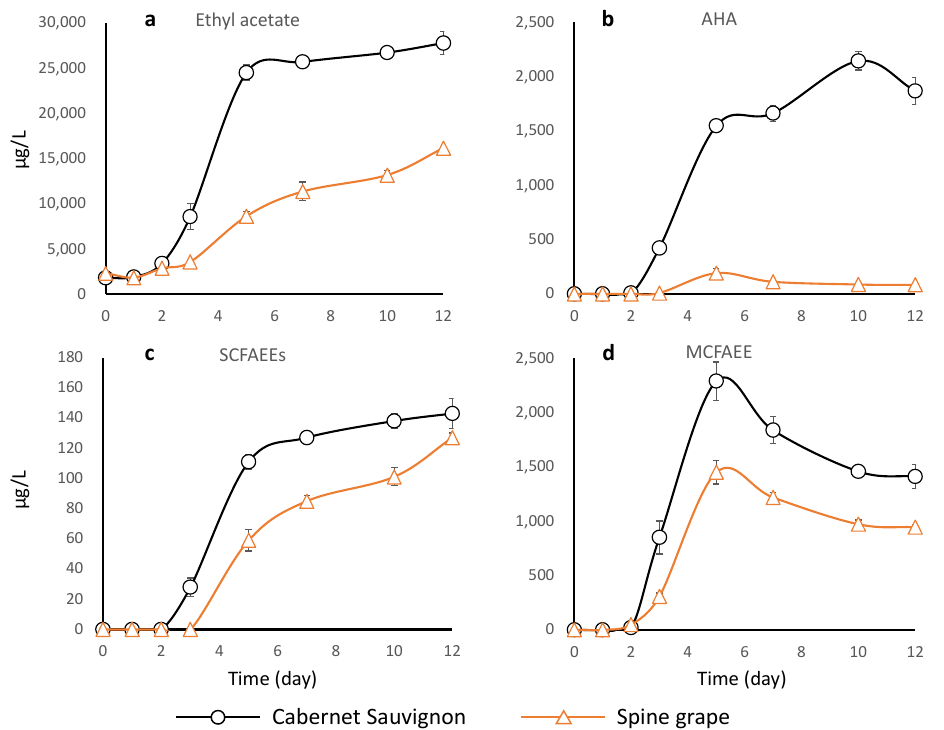
Figure 2. Evolution of fruity esters during Cabernet Sauvignon and spine grape alcoholic fermentation: ( a ) Ethyl acetate, ( b ) Acetate of higher alcohol, AHA, ( c ) Short-chain fatty acid ethyl ester, SCFAEE, ( d ) medium-chain fatty acid ethyl ester, MCFAEE. AHAs included isobutyl acetate, isoamyl acetate, hexyl acetate, and β -Phenylethyl acetate; SCFAEEs included ethyl butyrate; and MCFAEEs included ethyl hexanoate, ethyl octanoate, and ethyl decanoate.